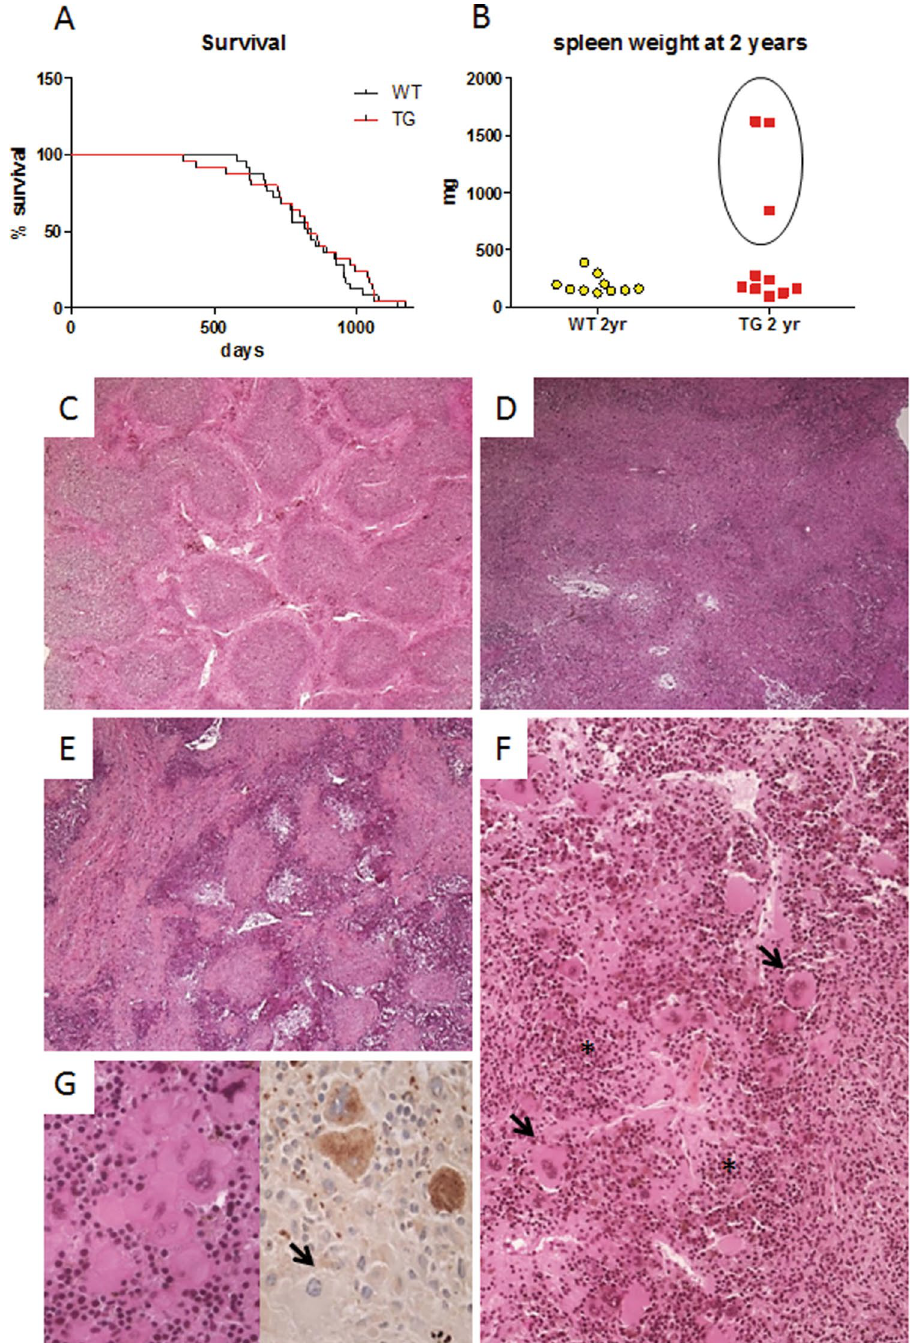
Figure 8. Calpastatin overexpression is associated to an increased frequency of spleen tumors. Most of CalpTG (TG) mice died with an abdominal distension due to a massive splenomegaly, there was no difference of survival rate between WT and CalpTG mice ( A , n = 25/group). Among the 10 CalpTG mice sacrificed at 2 years, 7 had an apparently normal spleen but 3 were affected by splenic tumors, compressing abdominal organs ( B ). Aged WT mice spleens had a classical follicular architecture and white pulp containing regular lymphocytes ( C , magnification × 50). Splenic architecture was disrupted in CalpTG tumoral spleens, white pulp could not be differentiated from red pulp ( D , magnification × 50) and fibrosis was evident in the most severe cases ( E , magnification × 50). Erythroblastic hyperplasia with evidence of dyserythropoiesis ( * ), and compact megacaryocytes clusters with nuclear atypia (arrows) were typical features of abnormal myeloid intrasplenic proliferation ( F , magnification × 200). The partial loss of factor VIII expression by megacaryocytes (arrow) among clusters confirmed the myelodysplasic syndrome ( G , magnification ×